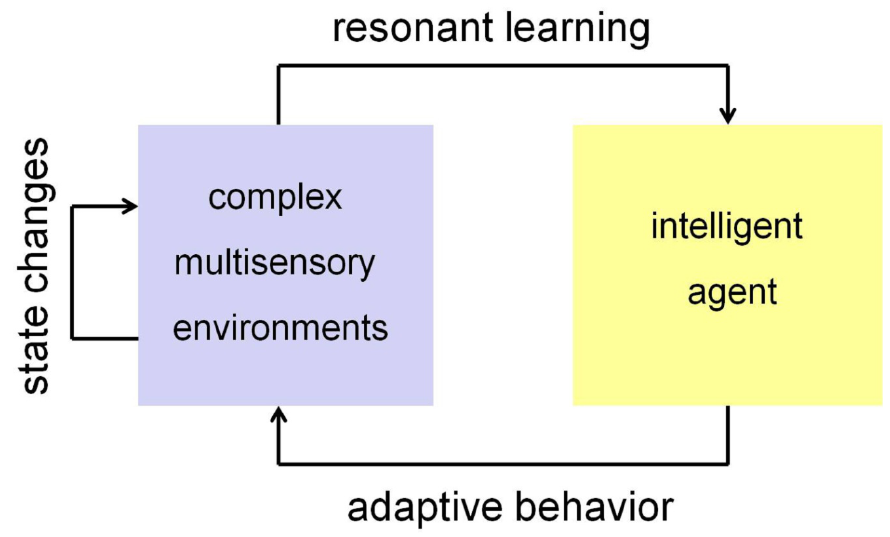
Figure 4. Adaptive resonance as a universal principle of biological learning gives intelligent agents the capability to cope and evolve with ever-changing multisensory environments on the basis of self-organizing adaptive behavior (interaction with the environment).